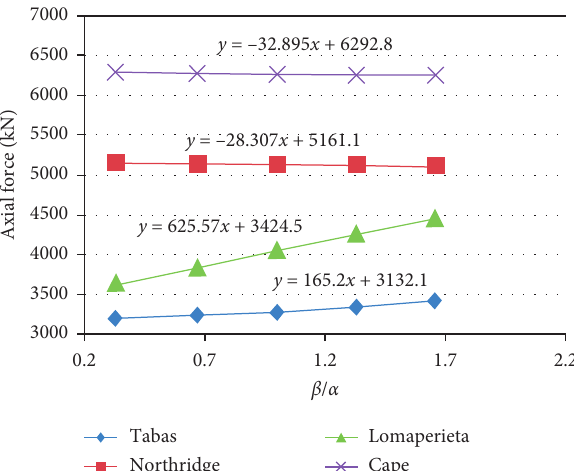
Figure 16: The maximum shear force of tunnel lining ( F ) at load combination 1 to 5.